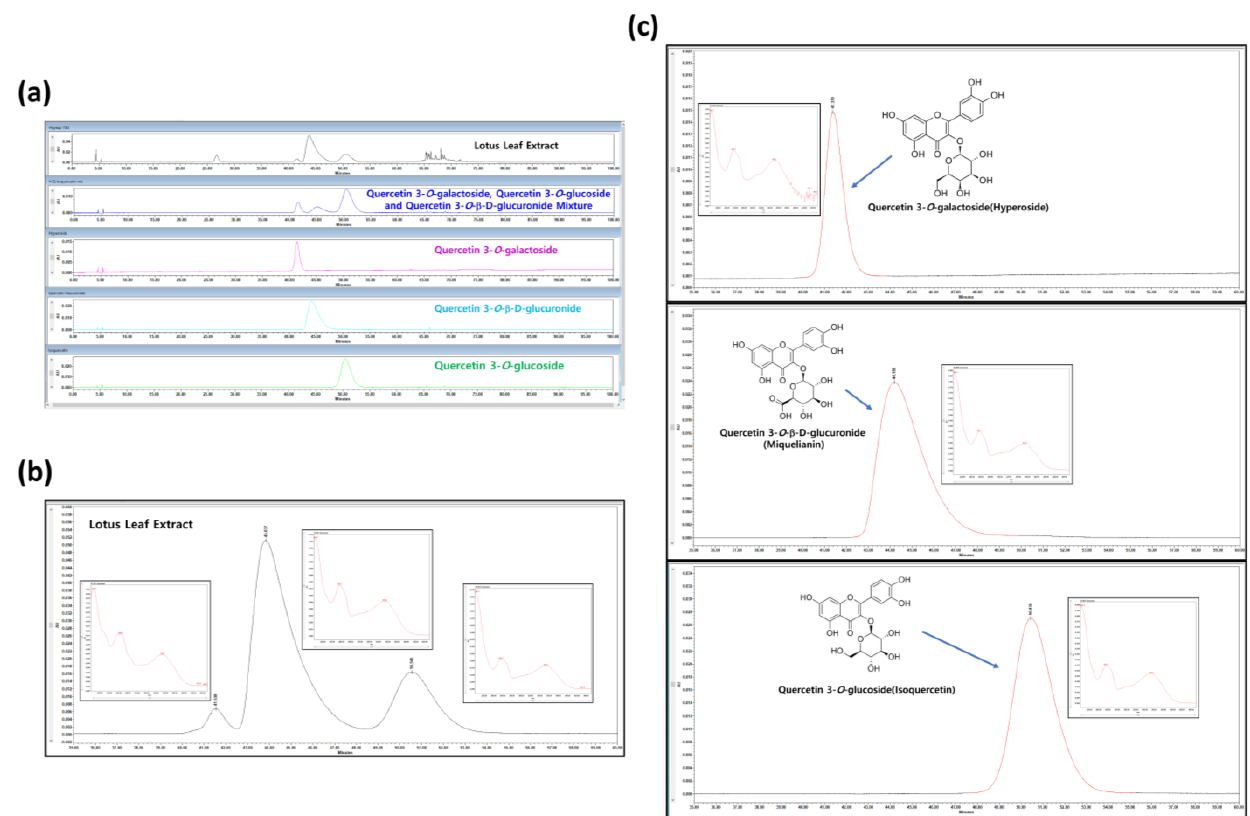
Figure 1. The HPLC analysis of NNL ethanolic extracts. The NNL ethanolic extract and three standards (Quercetin 3 − O − galactoside (hyperoside), Quercetin 3 − O −β− D − glucuronide (miquelianin), and Quercetin 3 − O − glucoside (isoquercetin)) were used in the HPLC analyses. ( a ) HPLC chromatograms comparing NNL extract and standards. ( b ) Photodiode Array (PDA) and HPLC chromatograms of NNL extract. ( c ) Photodiode Array (PDA) and HPLC chromatograms of reference standards.